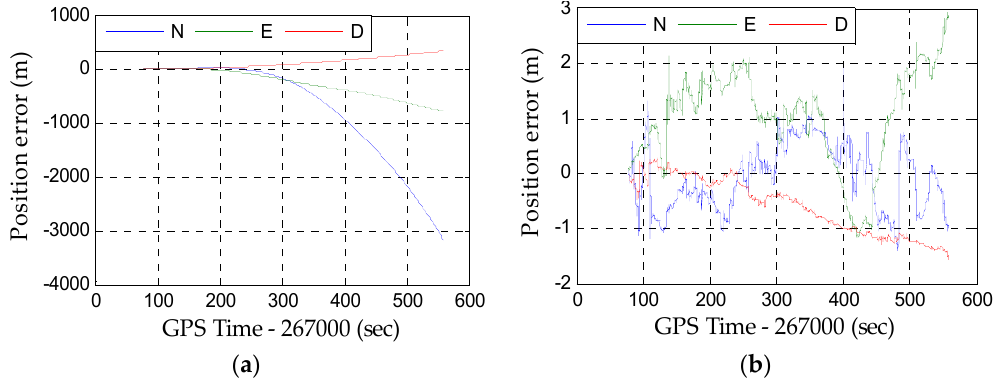
Figure 8. Position error in the north (N), east (E), and down (D) directions. ( a ) INS-only solution; ( b ) Vision-aided INS solution.